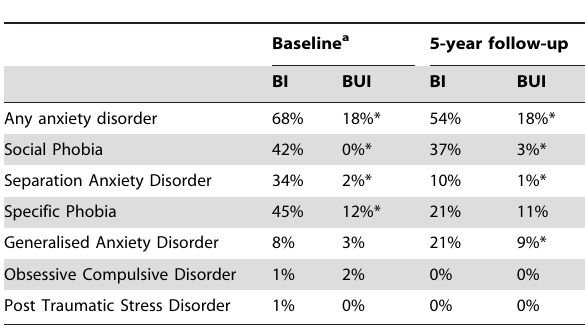
Table 1. Prevalence rates of anxiety disorders at 5-year follow-up for parent-reported behaviourally inhibited (BI) and uninhibited (BUI) groups.